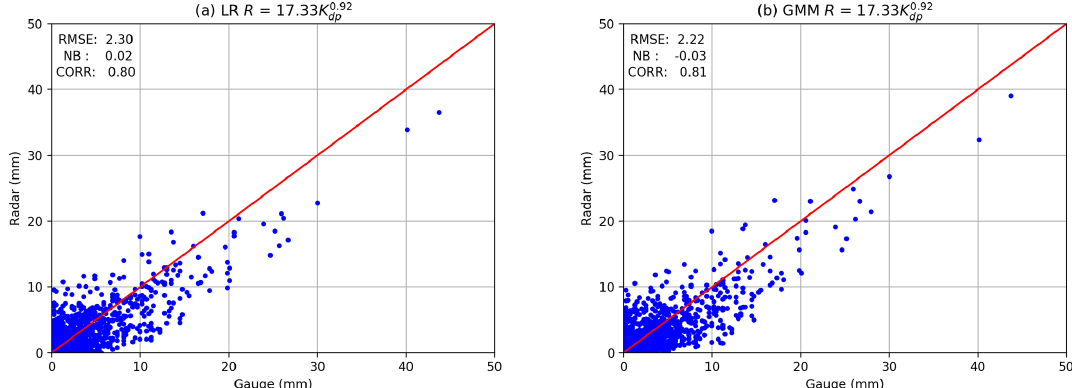
Figure 12. Same as Fig. 11 but for the optimal R – K dp relation for the four sites. (a) LR R(K dp ) and (b) GMM R(K dp ) . of the total differential phase